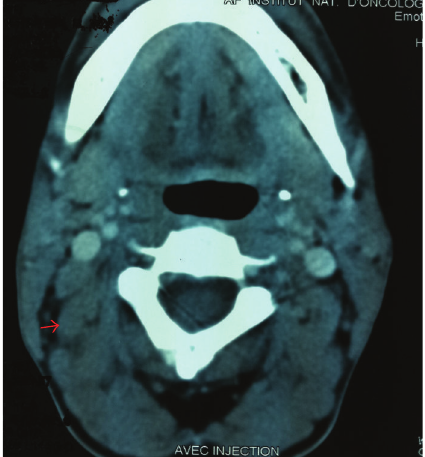
Figure 1: Computed tomography scan of the cervical showed a right cervical lymphadenopathy measuring 3 × 3